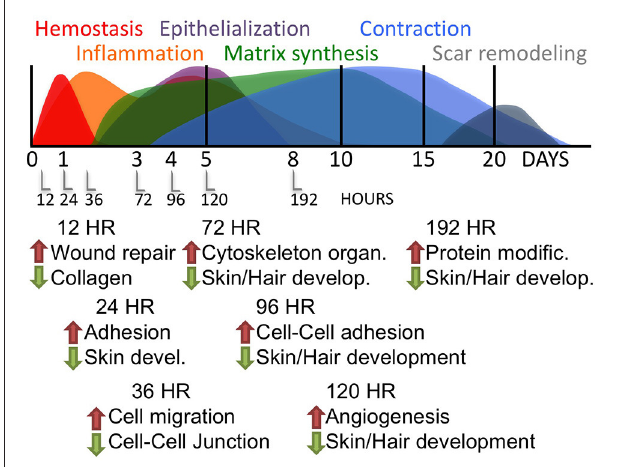
FIGURE 2 | Time-course of RNA response to skin wounds. Upper panel: A graphic summary of the major pathways engaged during mammalian wound repair as adapted from Seifert et al. (2012). Lower panel: The major gene ontologies of the transcripts regulated by wounding of the mouse skin, as detailed in Table 1 .